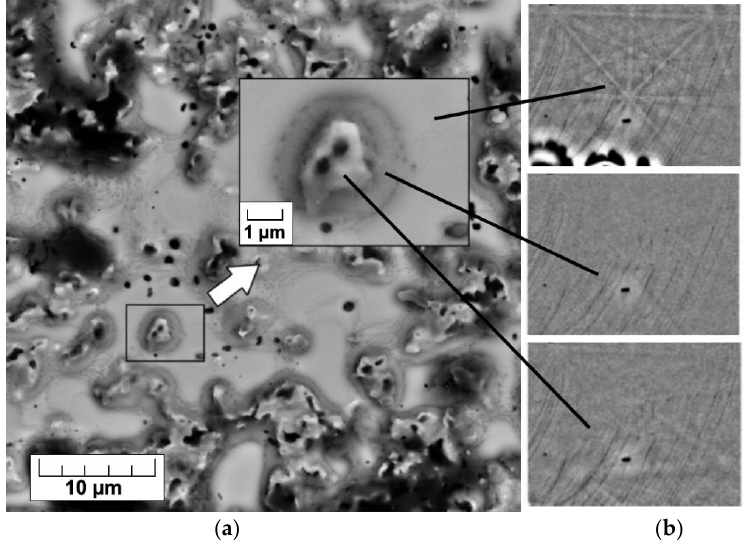
Figure 6. SEM image of the surface (~1 µm deep from the surface) of Fe-3%Si-0.5%Cu alloy with MgO coating after HTA ( a ) and diffraction Kikuchi-like pattern from different sites ( b ) (the upper pattern is the BCC-lattice diffraction, the lower pattern is the forsterite lattice).